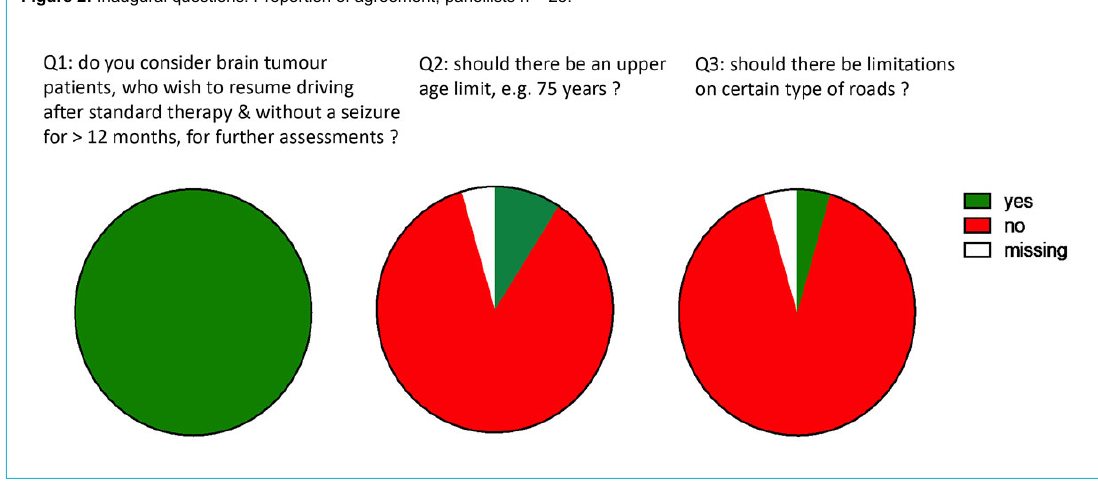
Figure 2: Inaugural questions. Proportion of agreement, panellists n = 23.